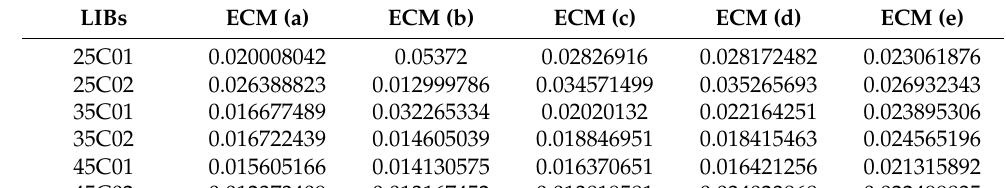
Table 4. The root mean square error (RMSE) of LIBs under different ECMs.